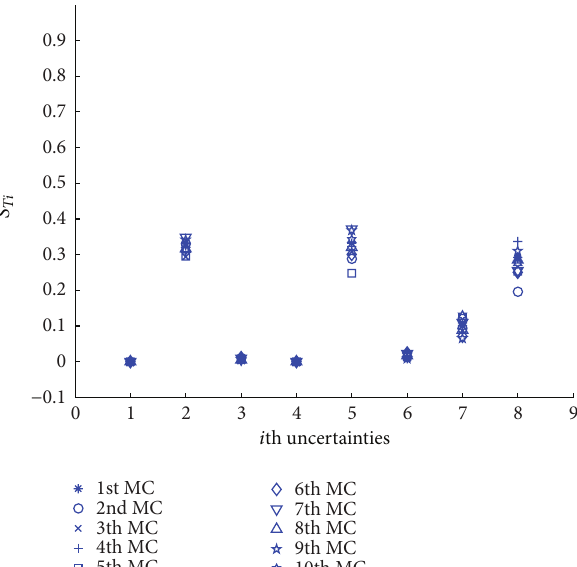
Figure 4: The global uncertainty sensitivity indices ( 𝑁 = 20000 ).